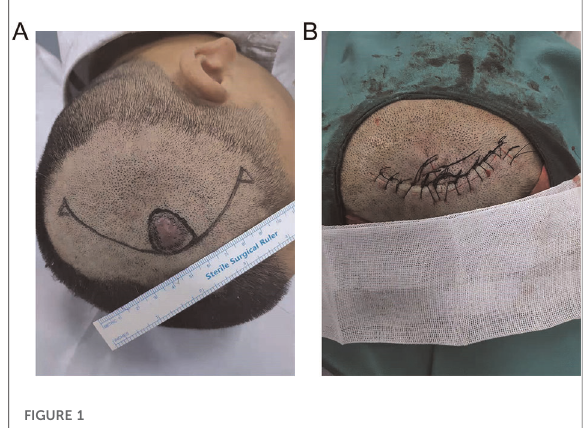
FIGURE 1 A-T advance fl ap operation. ( A ) Image before operation. ( B ) Image after the operation. A copy of the written consent is available for review by the Editor-in-Chief of this